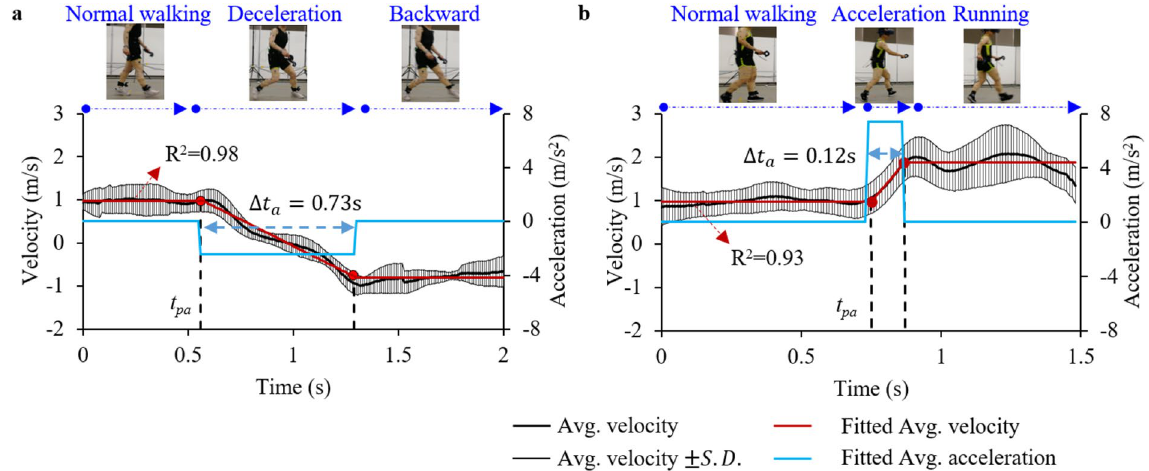
Figure 5. The whole-body kinematics of the pedestrian in the avoiding process of “bullet vehicle” by ( a ) backward and ( b ) forward motion. (cid:31) t a denotes the duration of acceleration or deceleration (shown: lab experiment